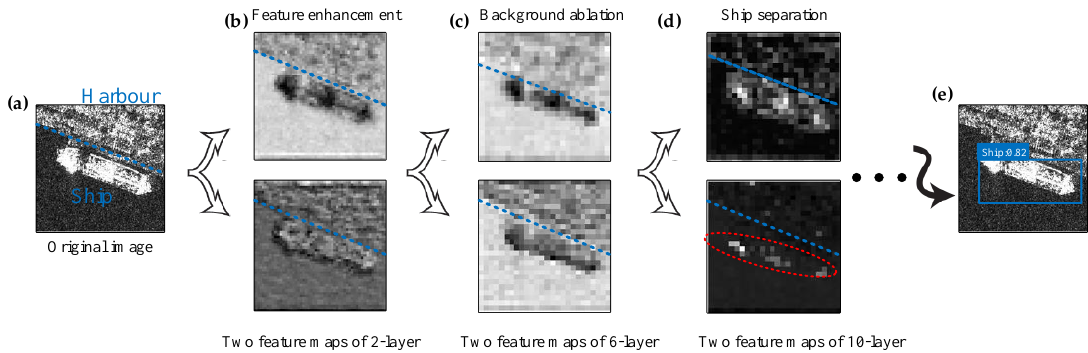
Figure 11. The process of feature extraction. ( a ) Origin image; ( b ) two feature maps of 2-layer; ( c ) two feature maps of 6-layer; ( d ) two feature maps of 10-layer; ( e ) detection results.